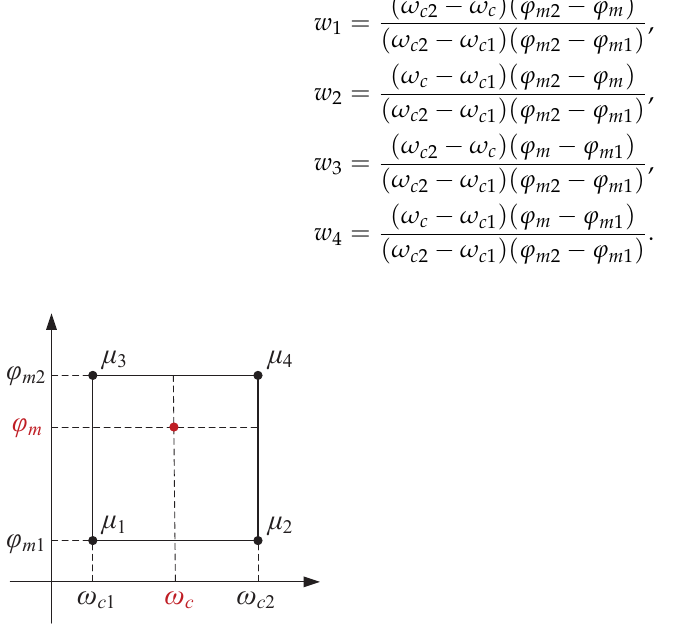
Figure 3. Estimation of the derivative order based on the four nearest rectangular points.